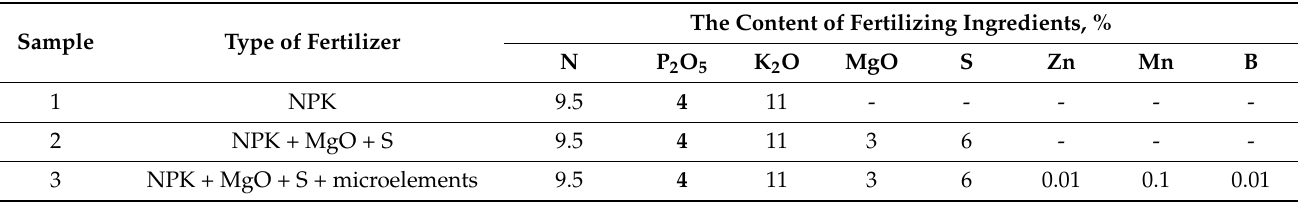
Table 7. Composition of fertilizers of the 1st series with the main composition of NPK: 9.5–4-11. Sample